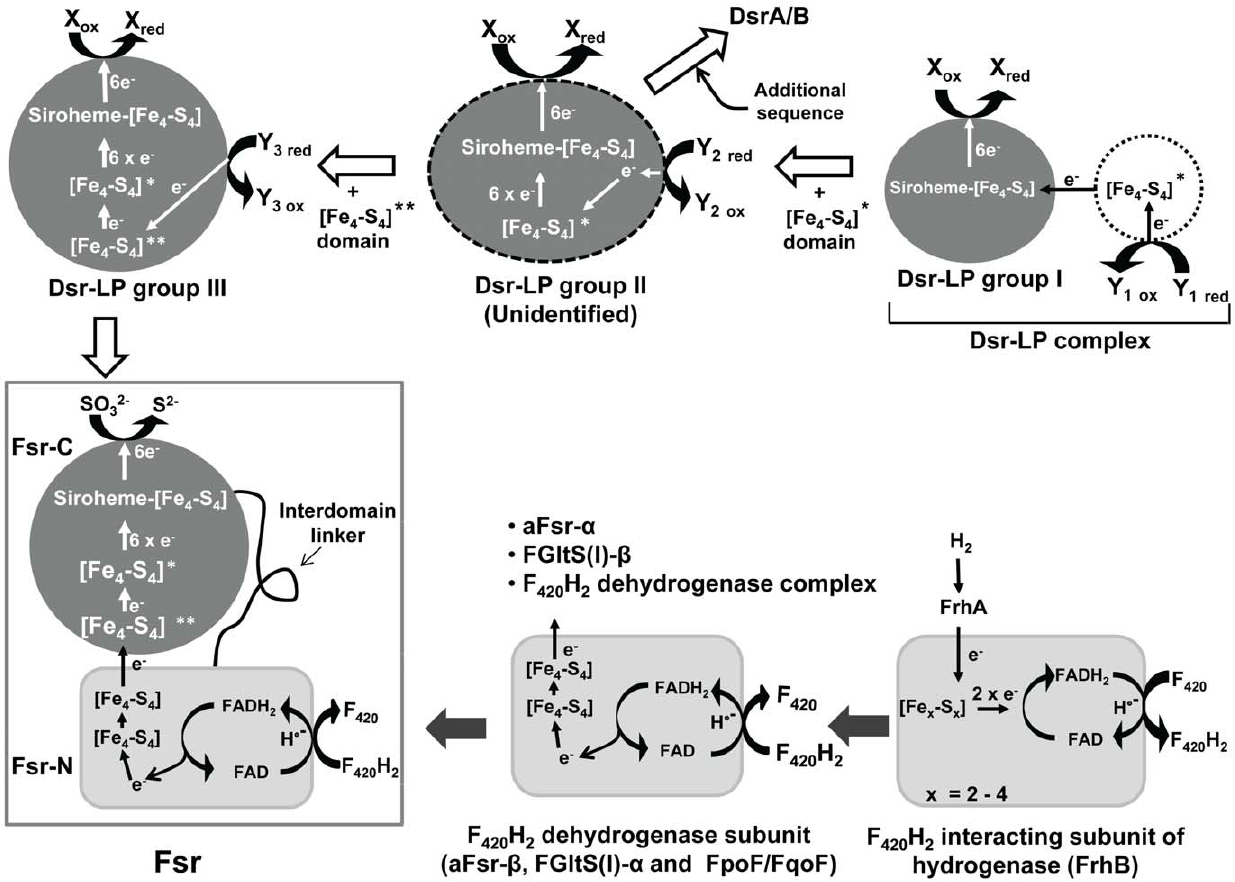
Figure 1. Development of dissimilatory sulfite reductase-like protein (Dsr-LP), F 420 H 2 -dependent sulfite reductase (Fsr) and dissimilatory sulfite reductase (Dsr). Fsr-N and Fsr-C: N-terminal and C-terminal halves of Fsr, respectively. FGltS(I)- a and FGltS(I)- b : F 420 H 2 dehydrogenase and glutamate synthase subunit of a putative F 420 H 2 -dependent glutamate synthase of methanogens; FpoF/FqoF: F 420 H 2 dehydrogenase subunit of a membrane-bound proton pumping F 420 H 2 dehydrogenase complexes of late evolving euryarchaea [36]; aFsr- a and aFsr- b : aSir and F 420 H 2 dehydrogenase subunits of a putative F 420 H 2 -dependent assimilatory type siroheme sulfite reductase found in haloarchaea. * and ** are peripheral and additional iron sulfur cluster [Fe 4 -S 4 ], respectively. Filled and unfilled boxed arrows show the path for the development of Fsr-N and Fsr-C, respectively. Dashed oval or circle, unidentified protein. X and Y 1–3 , unknown electron acceptors and donor, respectively.